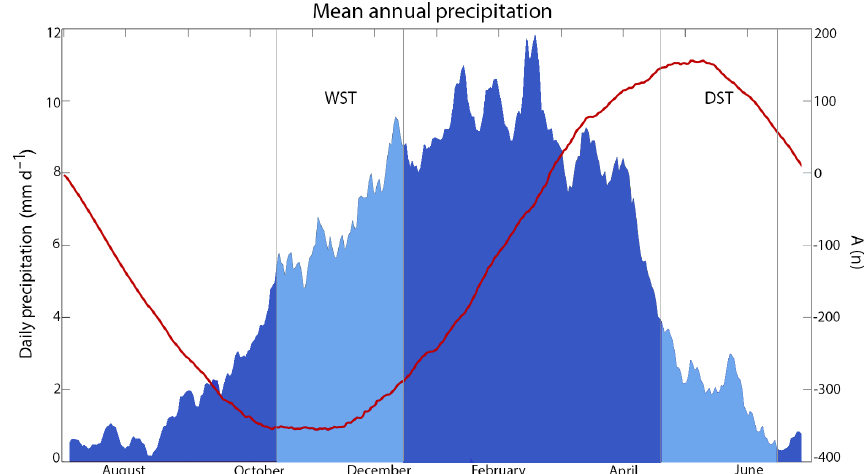
Figure 3. Mean annual precipitation of the study area calculated from TRMM with a 7d average for graphical smoothing. Wet season transition (WST) and dry season transition (DST) periods are represented in lighter blue. The vertical lines represent the average start and end dates; however, exact dates were calculated per year between July 2001 and July 2012. The red line represents the anomalous accumulation method A(n) from Liebmann et al.